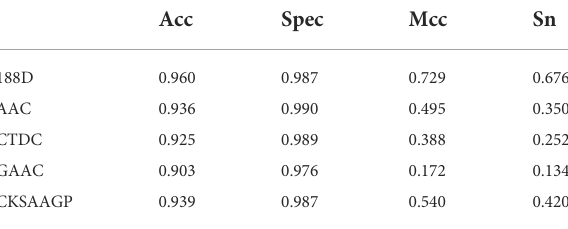
TABLE 5 Comparison of Sn, Acc, Spec, and Mcc values obtained by using GHKNN-based classi fi cation on this experimental dataset using fi ve extraction feature methods: 188D, AAC, CTDC, GAAC, and CKSAAGP.